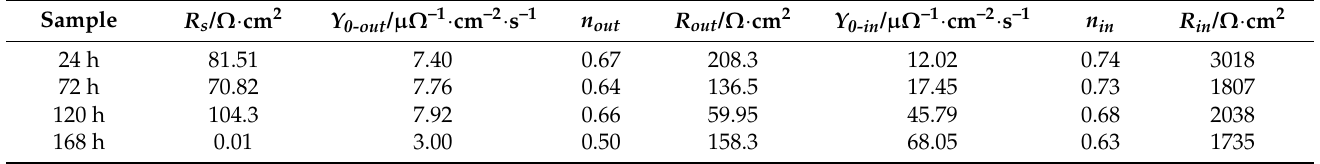
Figure 12. Equivalent circuit used to fit EIS plots and physical model of 12 h sample immersed for different times. Table 4. Fitting results of EIS plots for 12 h samples at different immersion times.